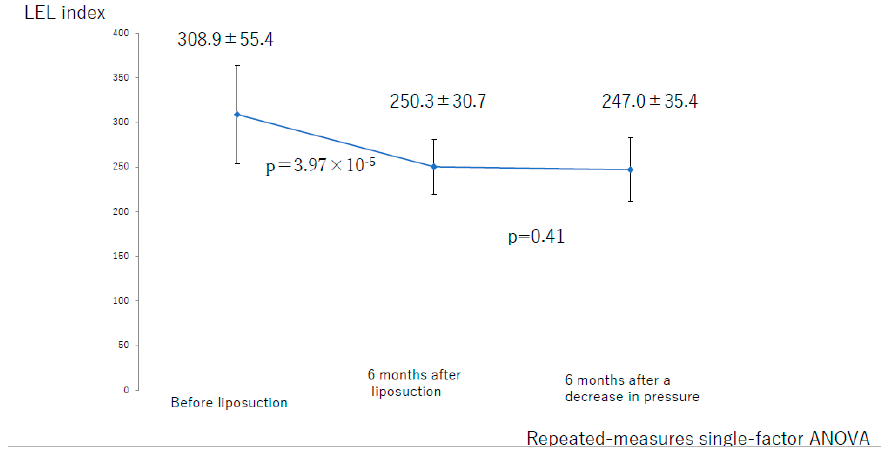
Figure 13. Changes in the LEL index over time in the entire study population. ANOVA, analysis of variance; LEL, lower extremity lymphedema.